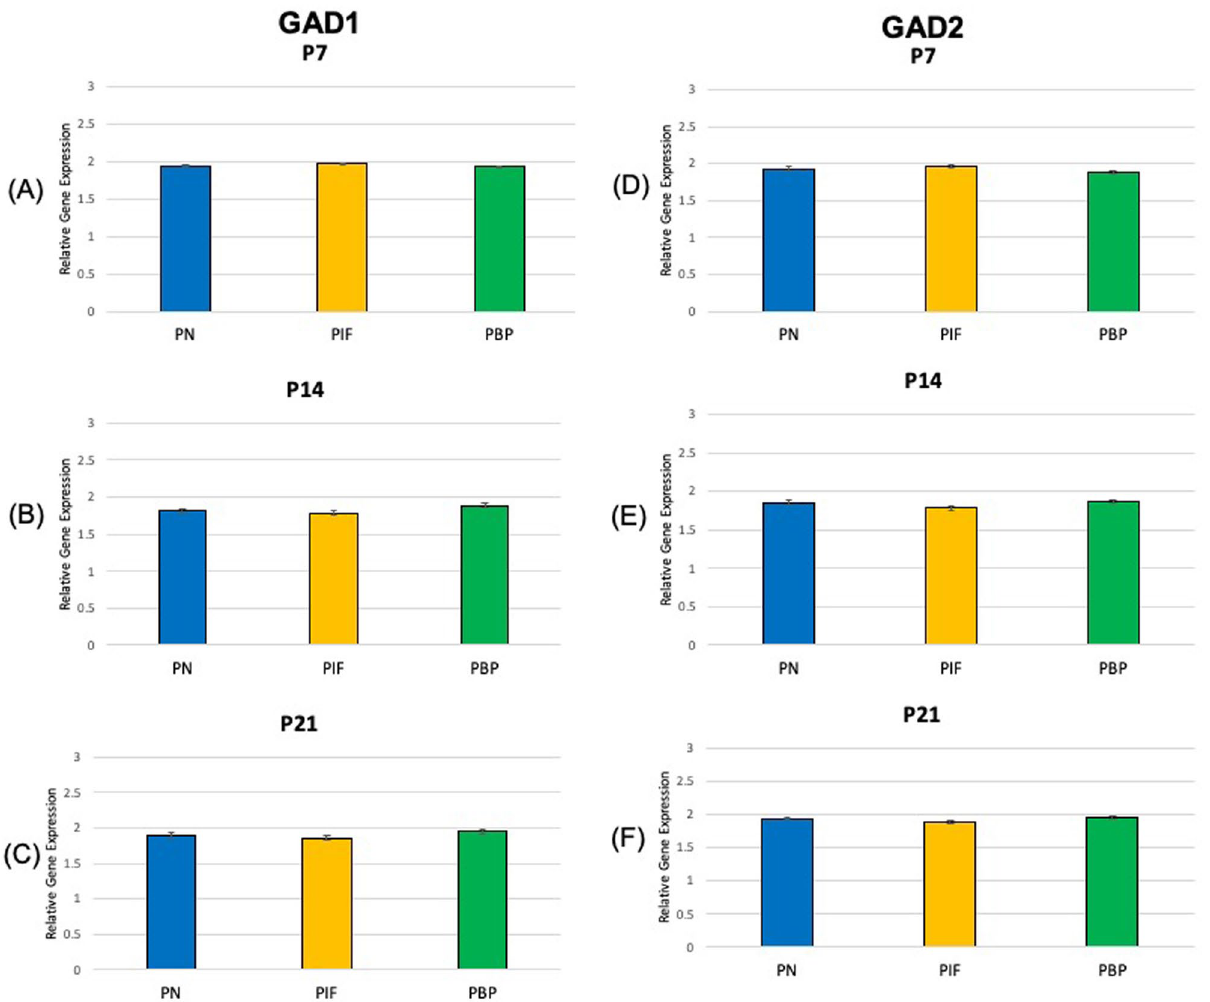
Figure 5. Relative gene expression of GAD1 and GAD2 in the VTA sub-regions (PN, PIF, and PBP) of nicotine exposed pups normalized to nicotine treated whole VTA midbrain samples. qPCR was used to identify the expression levels of GABA neurons for the ( A ) GAD1 P7, ( B ) GAD1 P14, ( C ) GAD1 P21, ( D ) GAD2 P7, ( E ) GAD2 P14, and ( F ) GAD2 P21 day old rat pups. ***p < 0.001, standard deviation. **p < 0.01, ± standard deviation. *p < 0.05 ± standard